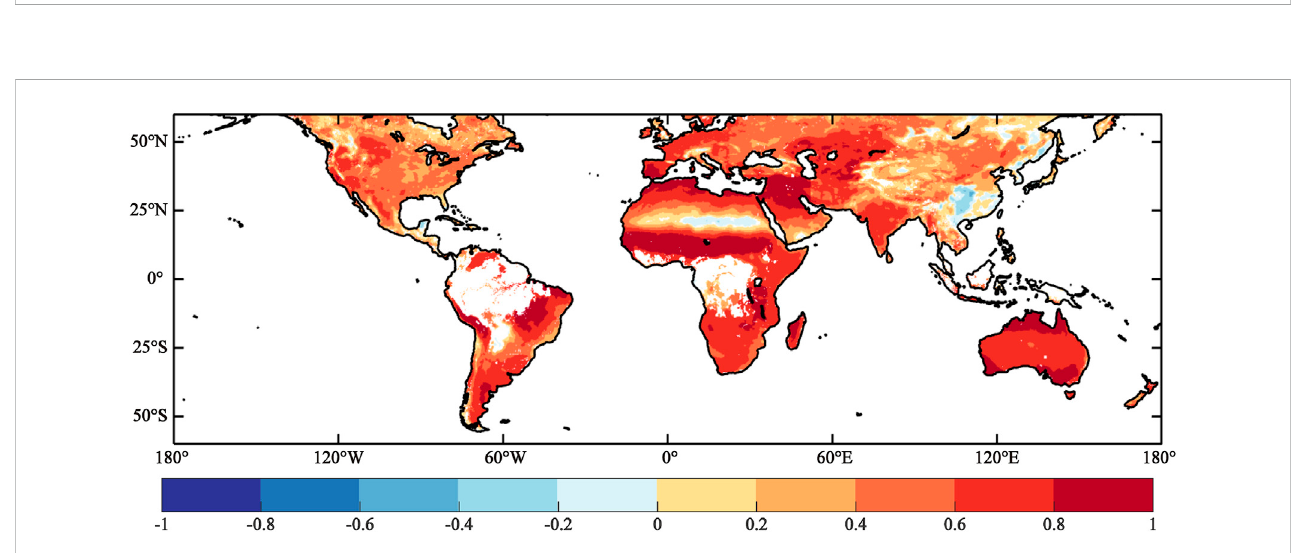
FIGURE 13 Pixel-wise correlation coef fi cients between CCI rec with CM rec using data of their overlapping period.